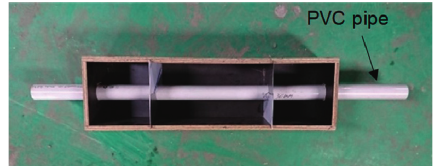
Figure 12: Wooden mold with PVC pipe.